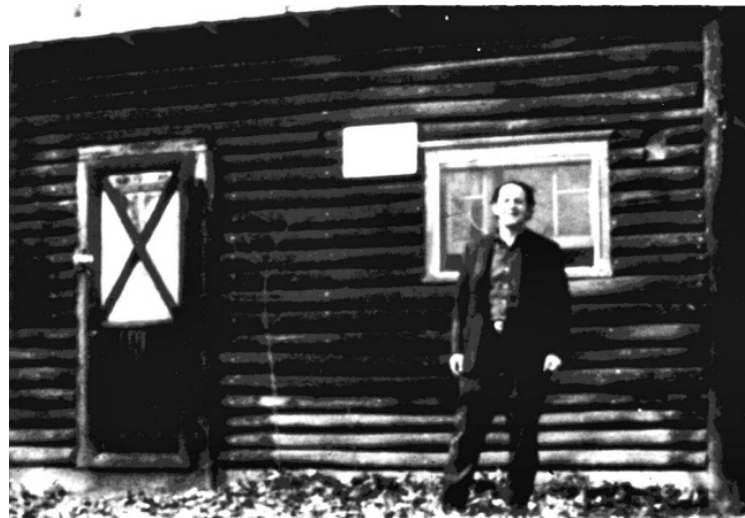
Figure 2. Eugene Garfield in front of the converted chicken coop in Thorofare, NJ, where he started the Science Citation Index. With permission from Eugene Garfield’s personal archive.